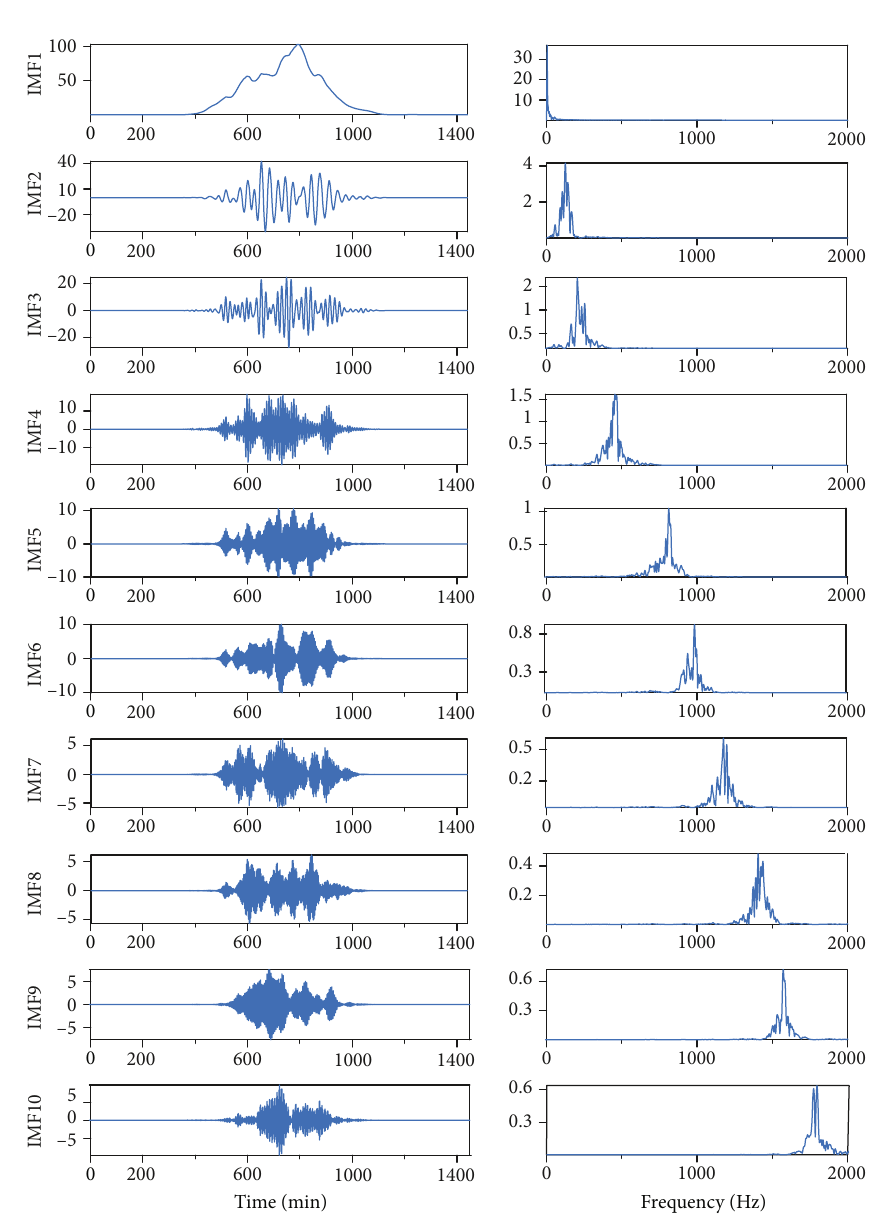
Figure 8: IHHO-VMD decomposition results.